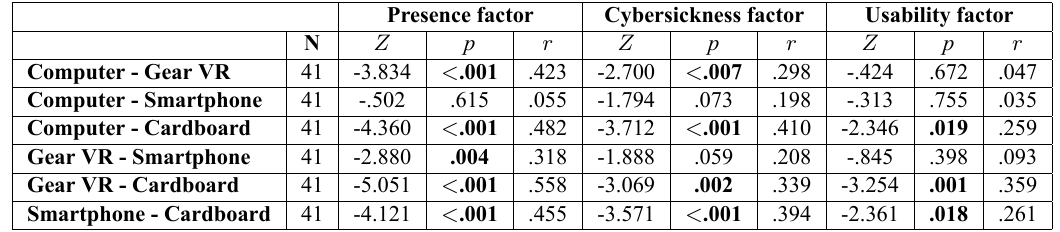
Table 8. Wilcoxon signed­rank test for the subscale scores for all pairs of devices in a within­subject perspective ( α = . 05 ).